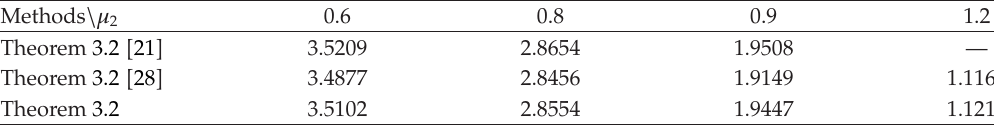
Table 1: Calculated MAUBs τ (cid:8) 1, unavailable μ max for l 1 in Example 4.1. Methods \ μ 2 0 . 6 0 . 8 0 . 9 1 . 2